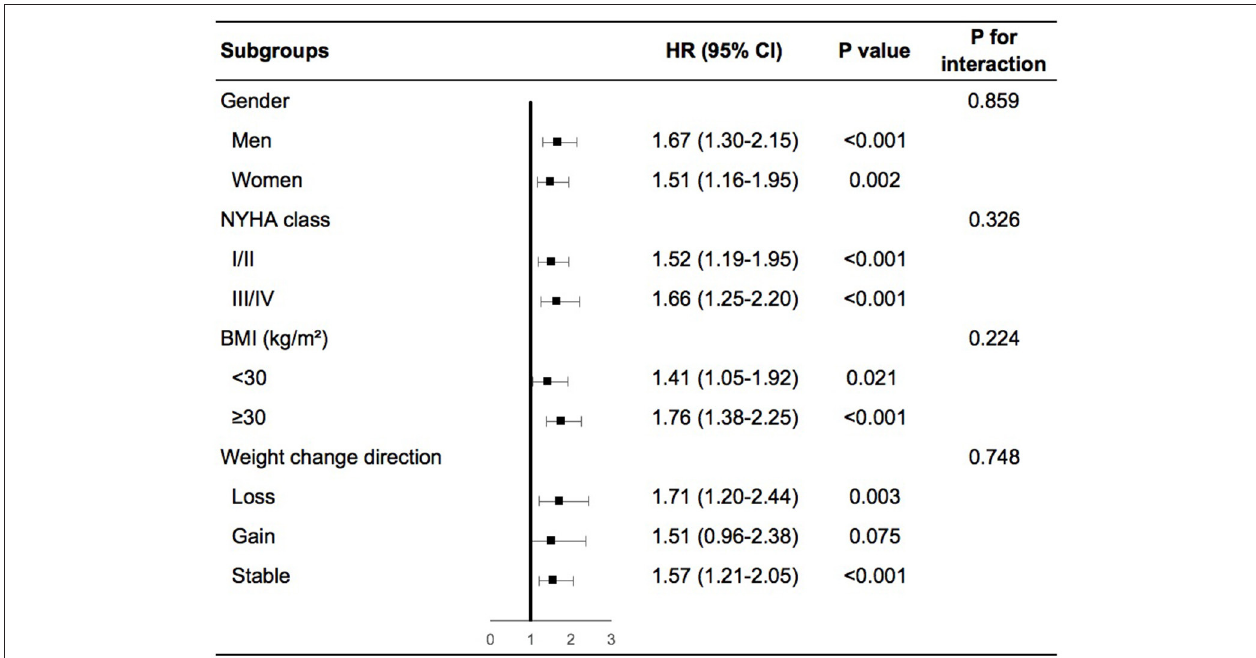
FIGURE 2 | Body-weight variability and risk of any cardiovascular events for various subgroups in multivariable model. The multivariable model was adjusted for diuretics, mean body weight, change in weight, age, sex, race, smoking status, diabetes status, atrial fibrillation, peripheral arterial disease, previous hospitalization for chronic heart failure, prior myocardial infarction, known stroke, chronic obstructive pulmonary disease, NYHA class, systolic blood pressure, heart rate, ejection fraction, estimated glomerular filtration rate, number of weight measurement. NYHA, New York Heart Association; BMI, body mass index; HR, hazard